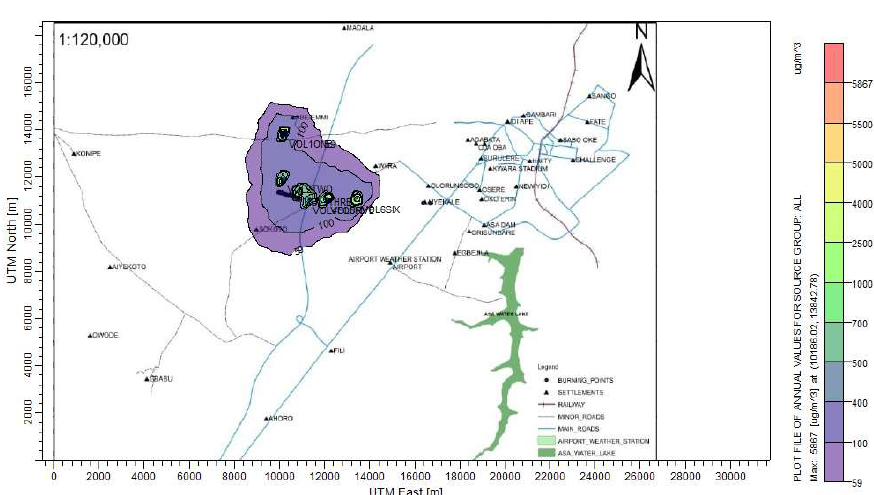
Figure 9. Isopleth of annual ground level NO x from Sokoto-Aiyekale dump